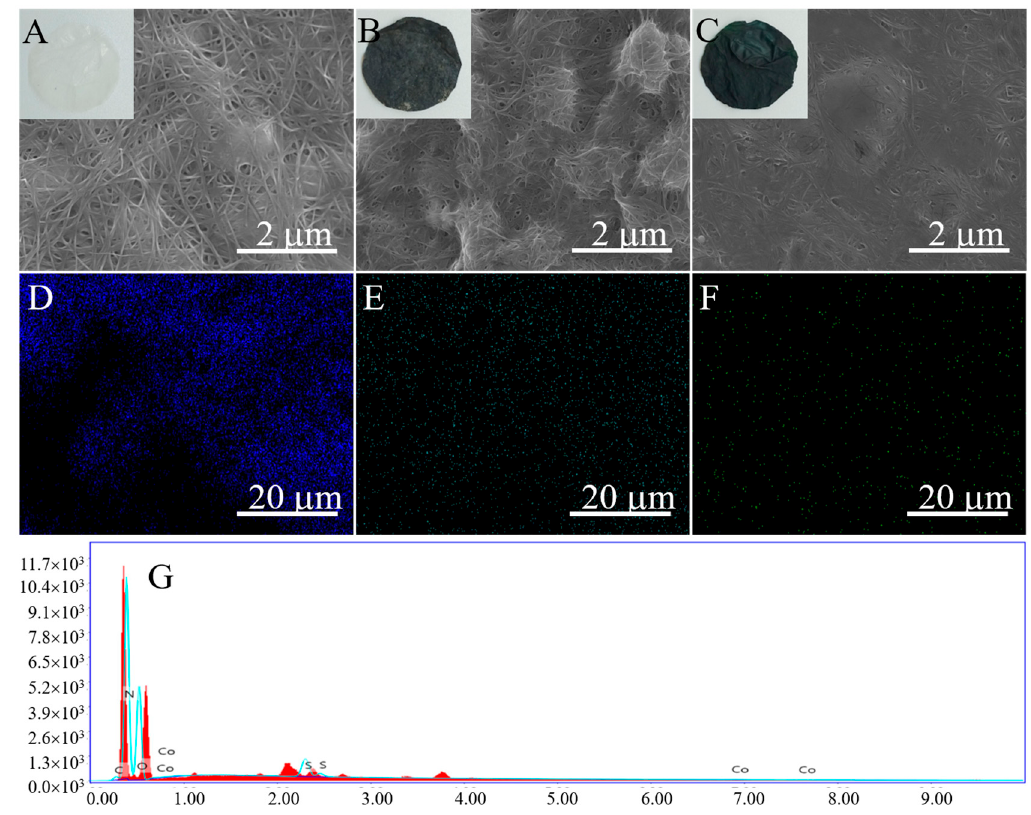
Figure 1. Field emission scanning electron microscope (FESEM) and optical images (inset) of ( A ) Figure 1. bacterial cellulose (BC); ( B ) graphene–bacterial cellulose (GBC), and ( C ) the prepared phthalocyanine–graphene–bacterial–cellulose nanocomposite (PcS@GBC); the elemental mapping images of N, S, and Co elements ( D , E , F ) and EDS spectrum ( G ) of PcS@GBC.